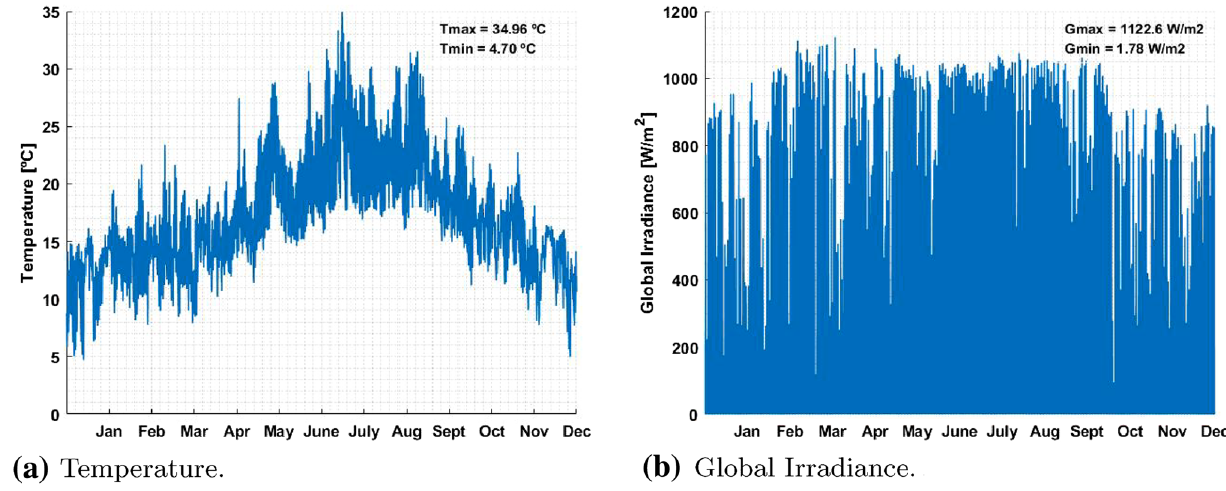
Fig. 8 External conditions data in Santa Iria de Azoia